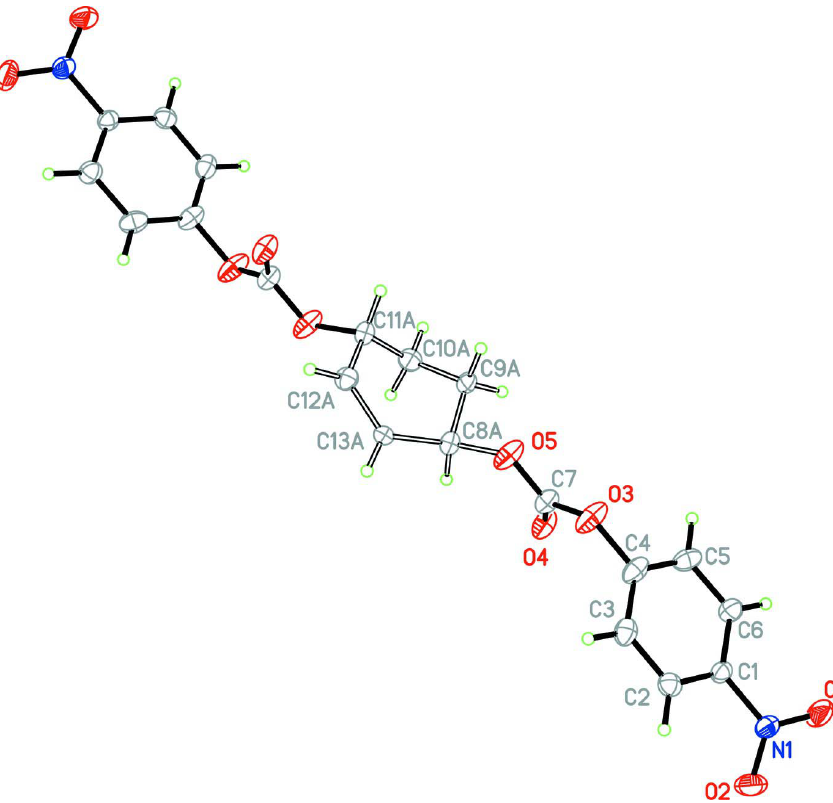
Figure 1 The molecular structure of (I) showing one component of disorder in the cyclohexene ring. Displacement ellipsoids drawn at the 30% probability level. Unlabeled atoms are related by the symmetry operator (1 - x , 1 - y , 1 - z